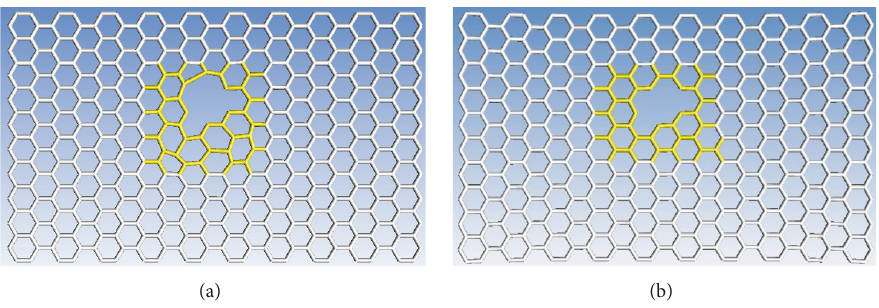
Figure 26: Physical meaning based editing for